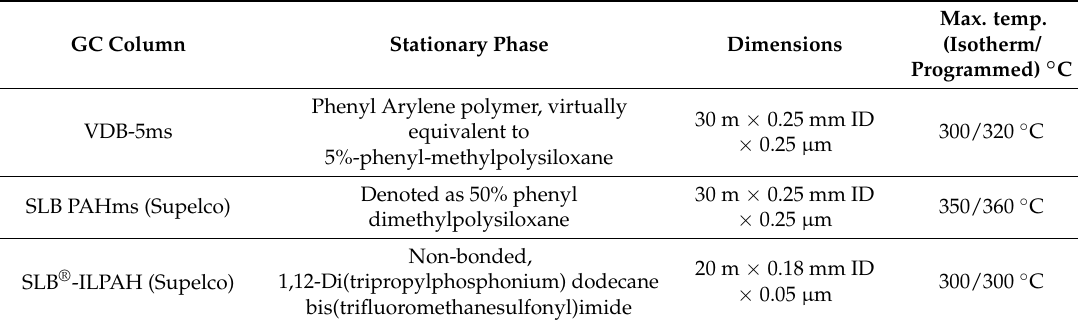
Table 1. Stationary phases and their